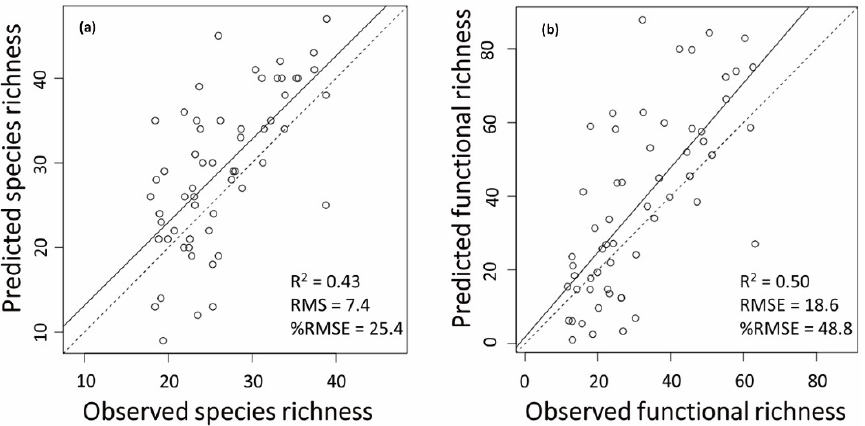
Figure 2. Comparison of observed versus predicted values for tree species richness ( a ) and functional richness ( b ). Dotted lines are 1:1 reference lines and solid lines are regression lines. The figure shows the coefficient of determination (R 2 ), root mean square error (RMSE), and percentage of RMSE (%RMSE). Table 2. Statistics of Random Forest models for estimating species richness and functional richness.